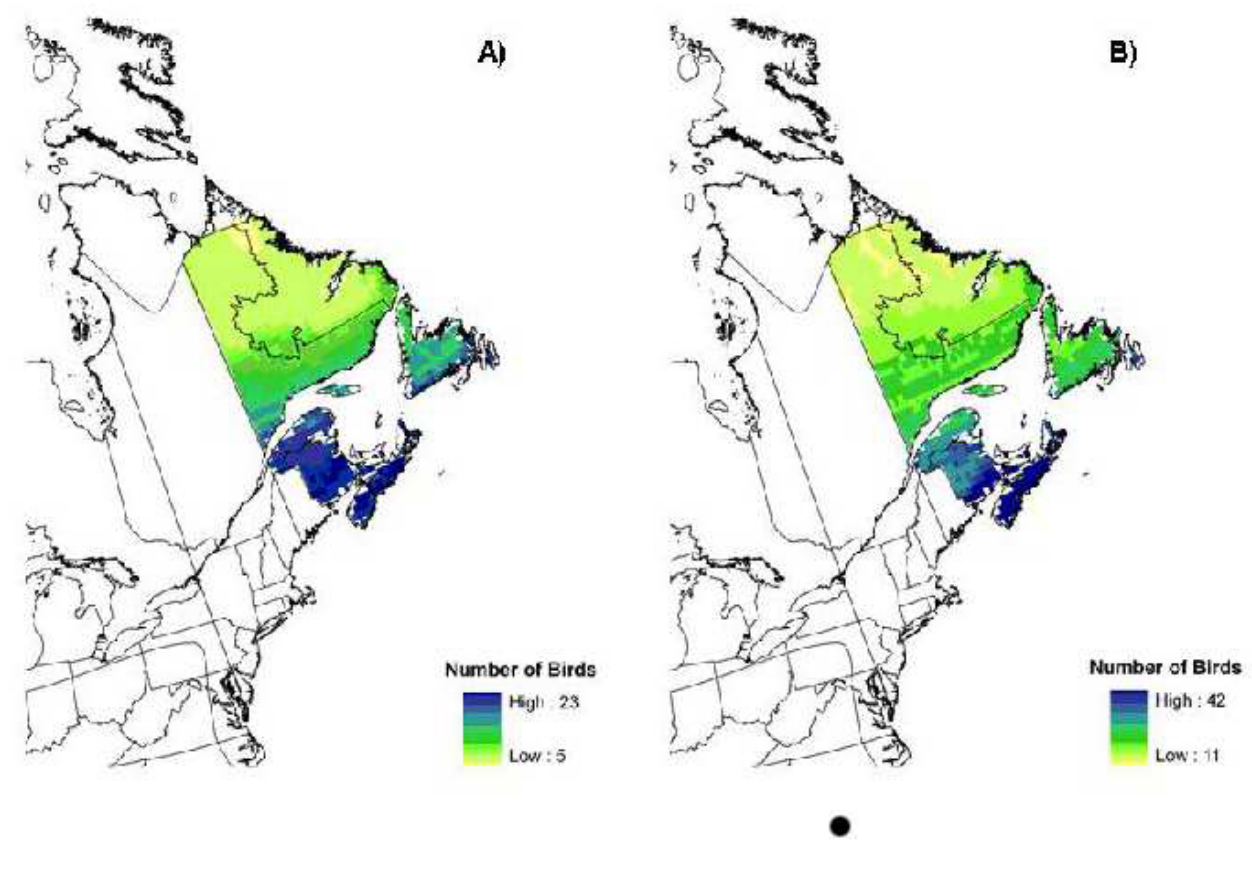
Fig. 2. Probable origins of American Black Ducks ( Anas rubripes ) harvested in the Eastern breeding/ harvest region during the 2005 hunting season for birds fed in A) agricultural areas ( n = 39) and B) in nonagricultural areas ( n = 68). A likelihood based assignment was used to place individuals to geographic origins on the basis of stable hydrogen isotope values (see Methods). The results displayed represent the sum of assignments across the samples (see